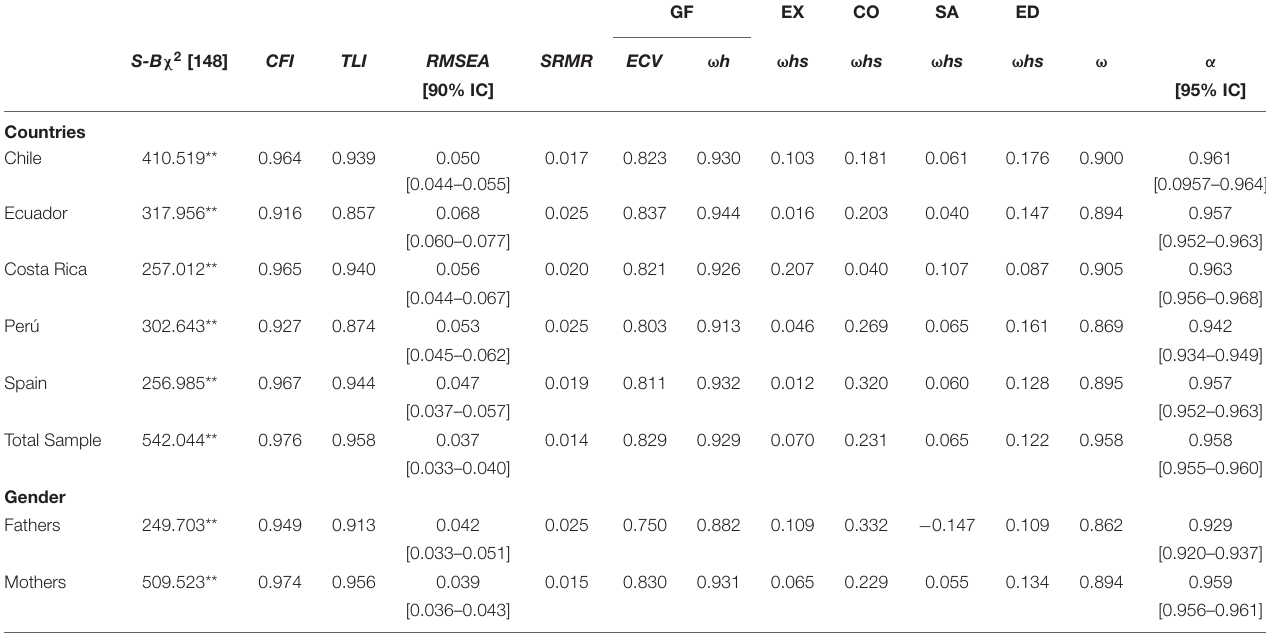
TABLE 2 | Bifactor ESEM model and reliability per country and